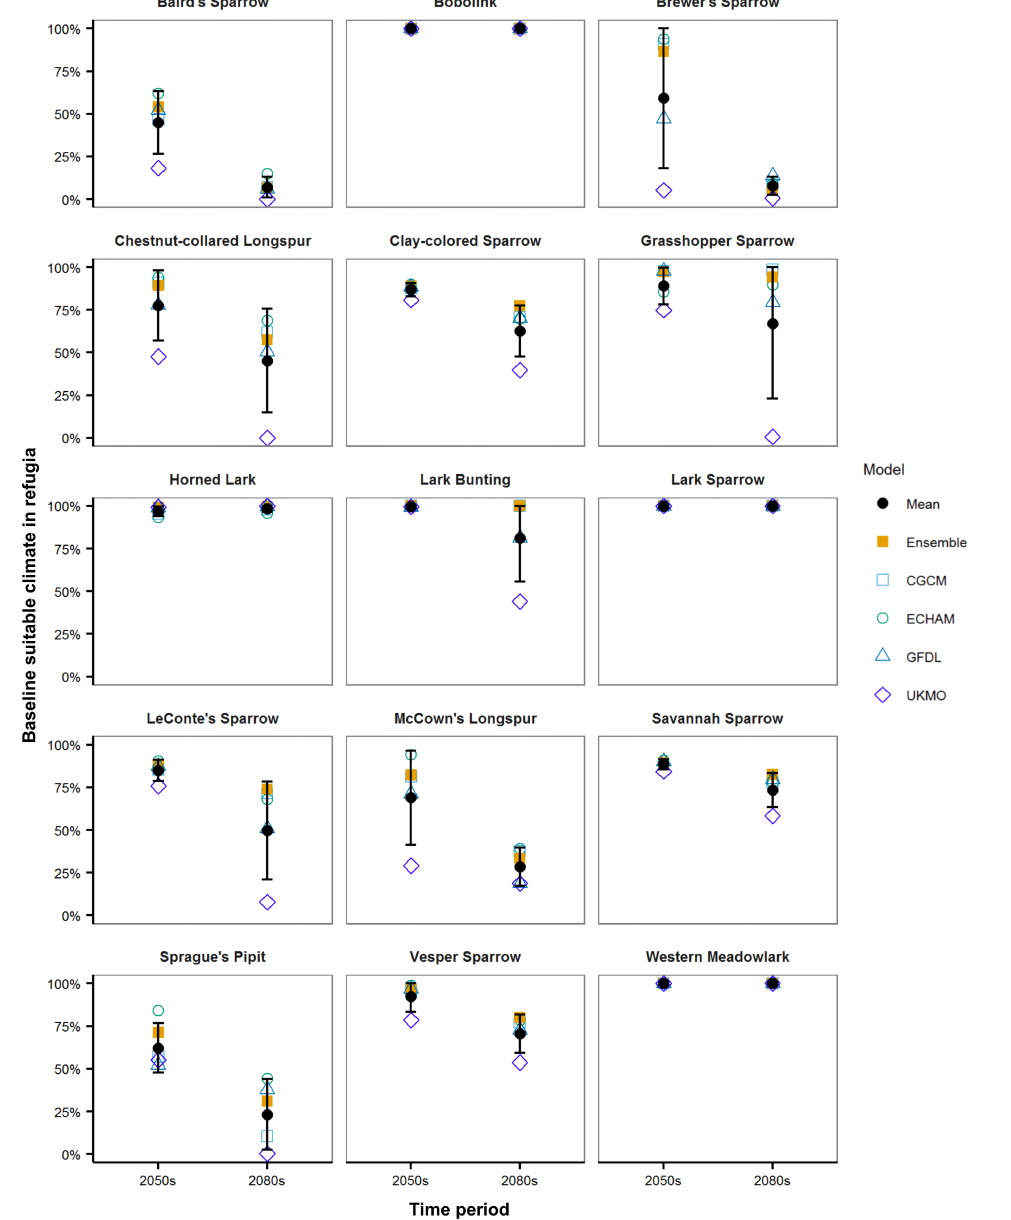
Fig. 3 . Percent of baseline (1961–1990) suitable climate projected to remain suitable in future time periods in Alberta, Canada based on North American models. The mean percent area (± 95% CI) was determined from the four unique global climate models. Symbols as in Fig.